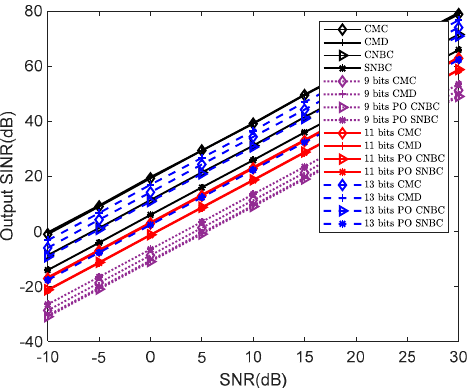
Figure 13. The output SINR versus SNR on different quantization bits.